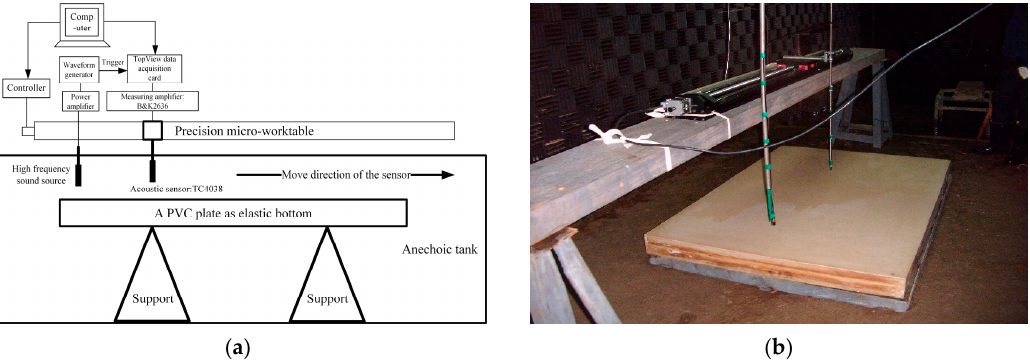
Figure 12. ( a ) Experimental measurement system, ( b ) The movable micro-worktable for measurement equipment.